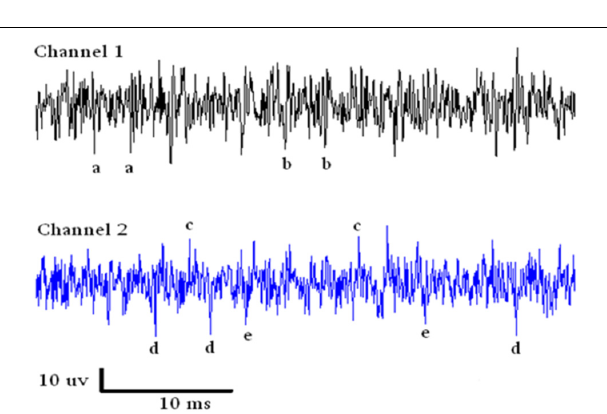
FIGURE 3 | Samples of continuous recording from both electrodes over a 40 ms time base. Due to the configuration of the electrode recording wires, SUs are detectable above and below the continuous stream of data. Thus with voltage level detection there are four channels of data. The lower case letters refer to single units that look similar in